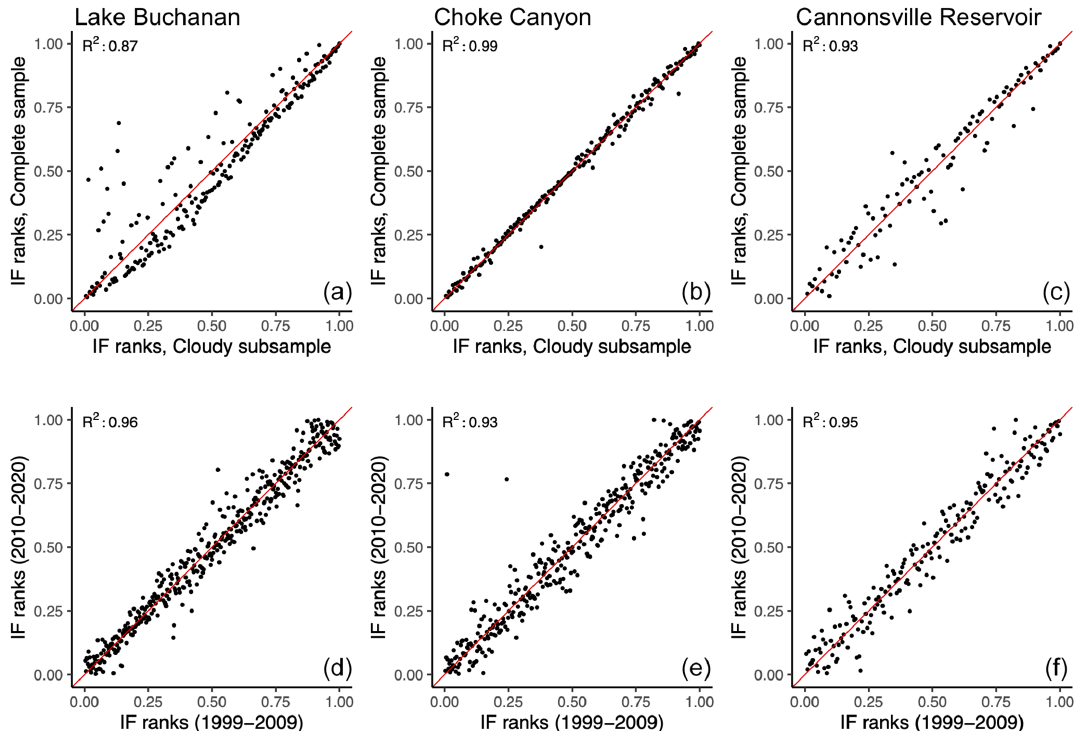
Figure 6. Assessment of the independence (a–c) and stationarity (d–f) assumptions for Lake Buchanan (a, d) , Choke Canyon Reservoir (b, e) , and Cannonsville Reservoir (c, f) . (a–c) Inundation frequency ranks per pixel estimated under cloudless conditions (unsupervised clas- sification; y axis) plotted against corresponding ranks estimated using the full sample of observations (combined supervised–unsupervised classification; x axis). (d–f) Inundation frequencies ranks per pixel estimated using the first ( x axis) and second ( y axis) half of the Landsat 7 observation period